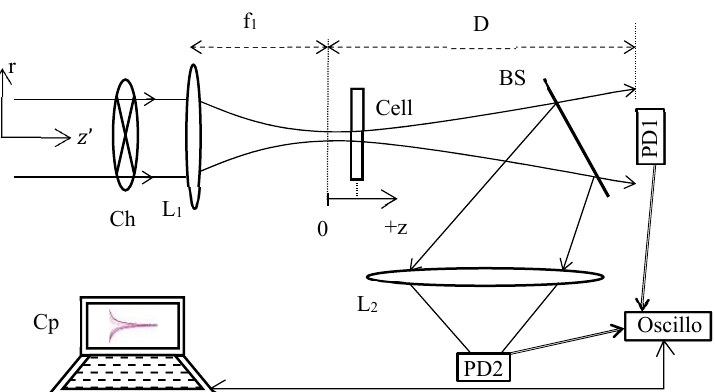
Figure 1. Scheme showing the different position of the optical elements. The cell is scanned along the beam direction around the focal plane (z = 0). The labels refer to: lens (L 1 , L 2 ), beam splitter (BS), chopper (Ch), computer (Cp) and photodiodes (PD1, PD2).